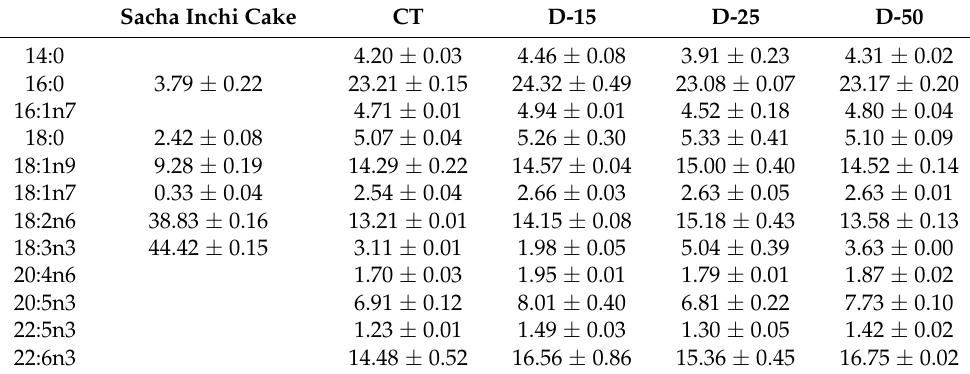
Table 3. Fatty acid composition (% fatty acids) of sacha inchi cake and the experimental diets used in the feeding